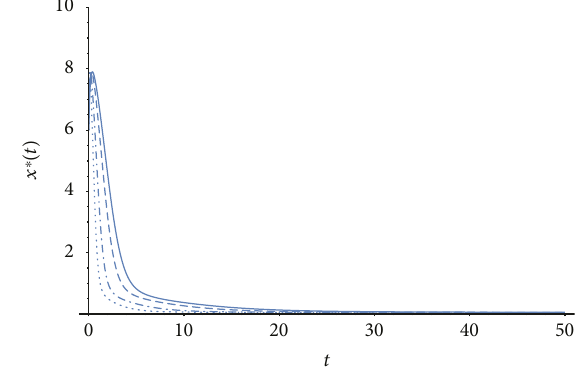
Figure 2: The graph represents the solution behavior for the variable x ⋆ t (concentration of infected cells) versus time t under di ff erent values of the order of derivative. The solid line, dashed line, dot-dashed line, and dotted line represent solution behavior at ζ = 1, ζ = 0 75, ζ = 0 85 , and ζ = 0 95 , respectively.